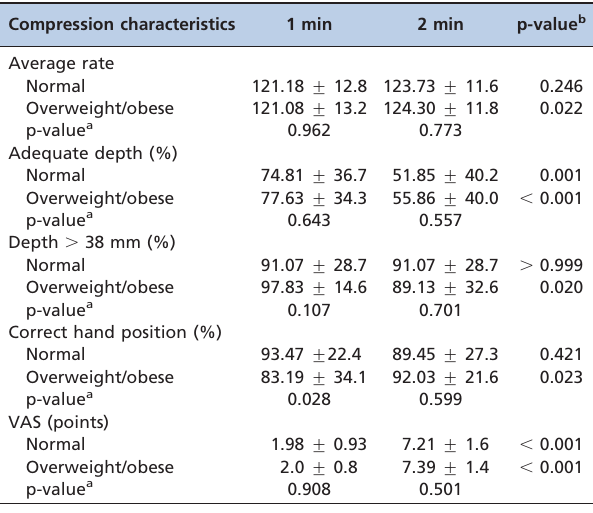
Table 4 - Quality of chest compressions performed for one and two minutes in relation to the body mass index of the